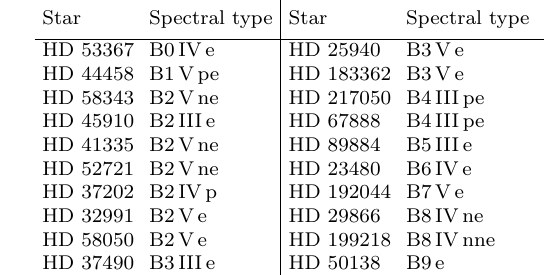
Table 1. The list of the studied Be stars and their spectral types.